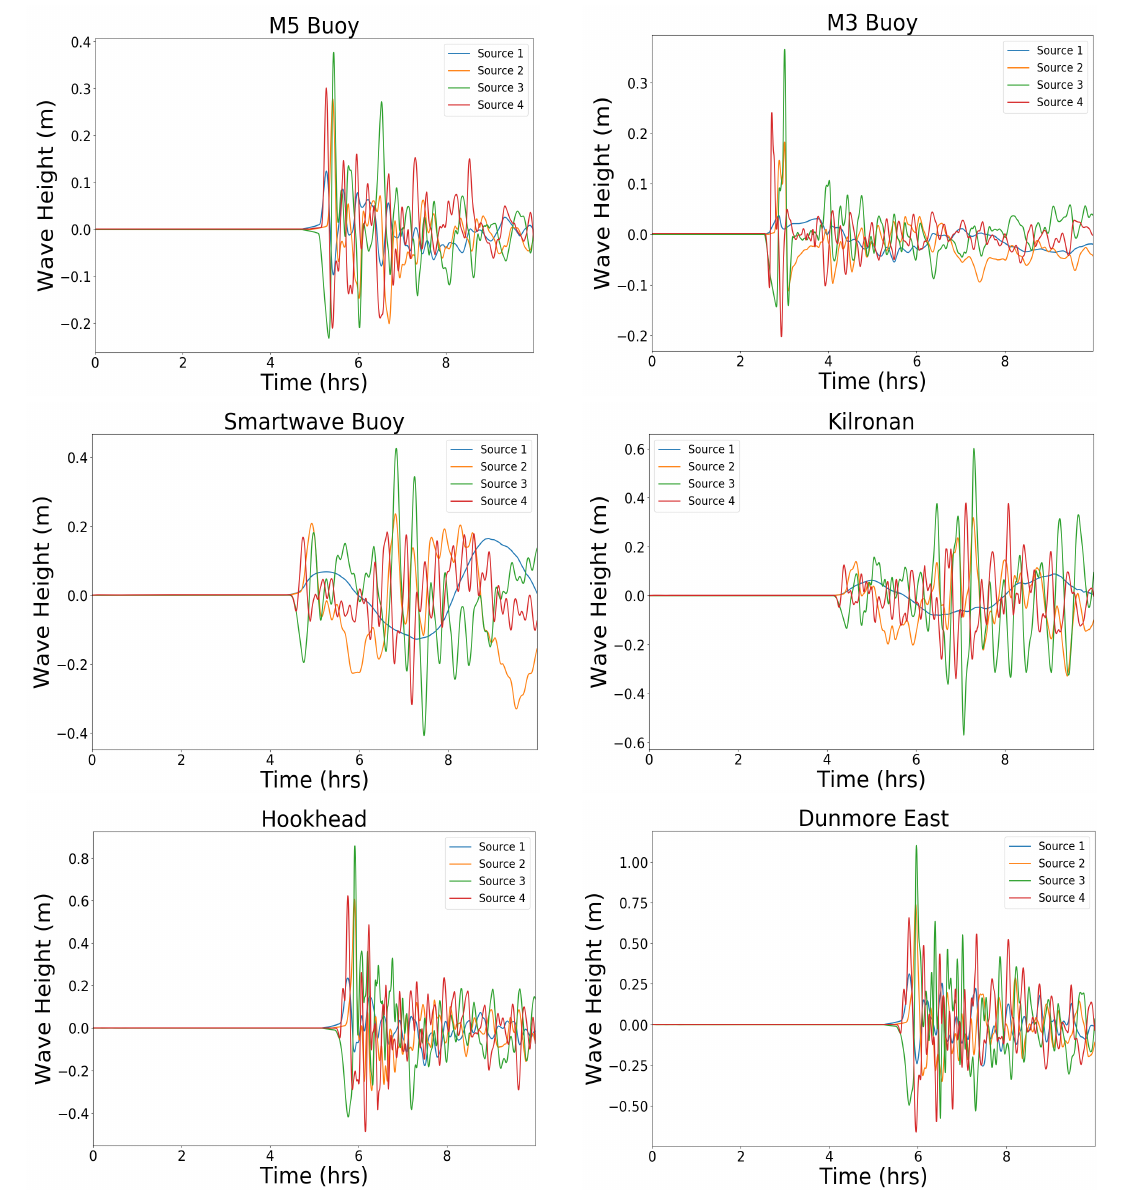
Figure 5. Wave gauge plots from selected locations around the coastline in Ireland. ( Top row ): Wave surface elevations from the four different sources at wave buoys located off the coast of Ireland. ( Middle row ): Water surface elevations from the four different sources at gauges located in Galway Bay. ( Bottom row ): Water surface elevations from the four different sources at gauges located in the Dunmore East